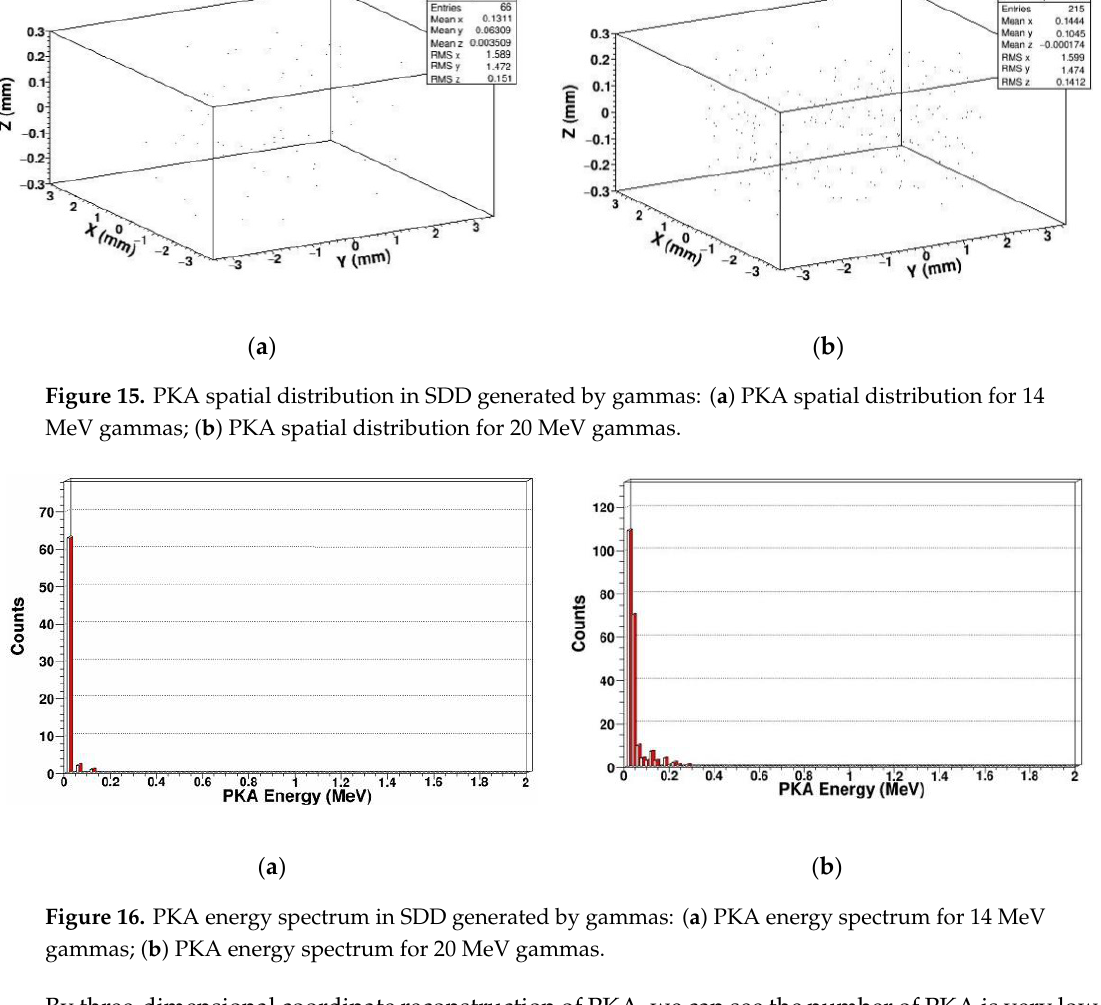
Figure 14. Track structure produced by gammas irradiating SDD.